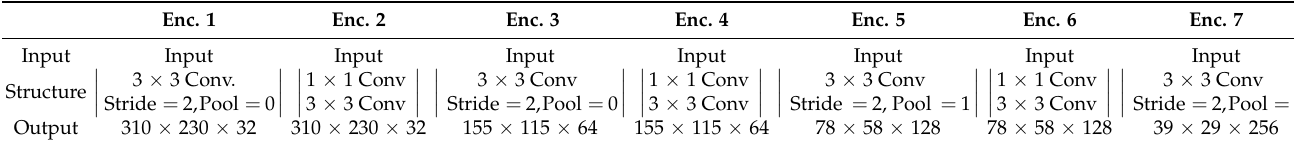
Table 1. Encoder structure.